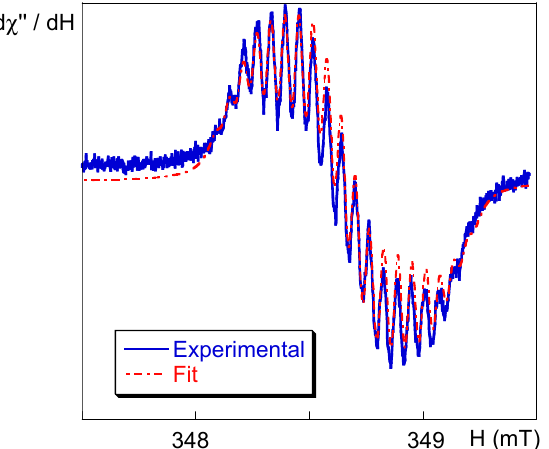
Figure 3. Experimental (blue line) and simulated (dashed red line) EPR spectra of radical [1] • in dimethylsulfoxide (DMSO)/water. Experimental details: modulation amplitude 0.02 mT, time constant 40.96 ms, conversion time 327.68 ms, gain 6.32 × 10 4 , power 20 mW, and microwave frequency 9.7768 GHz.